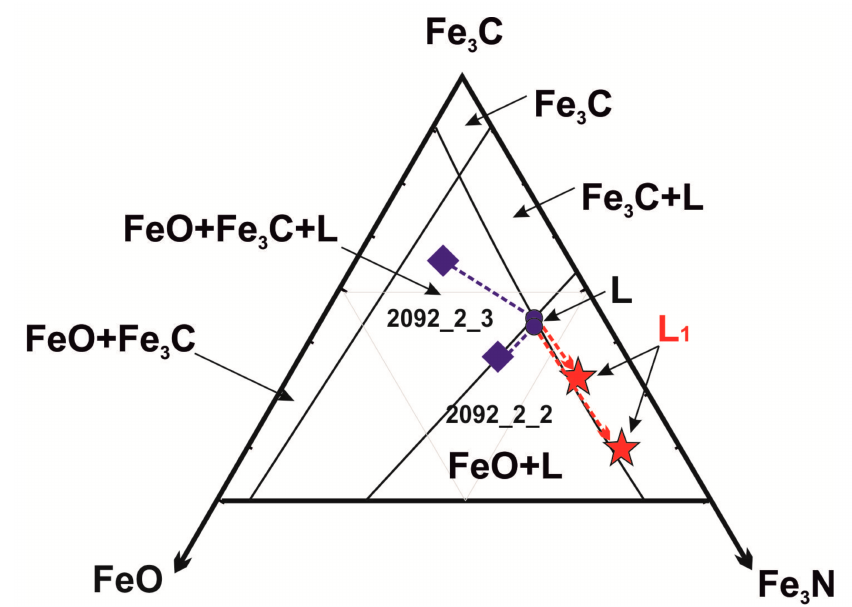
Figure 5. Fragment of FeO-Fe 3 C-Fe 3 N phase diagram at 7.8 GPa and 1350 ◦ C (mol %), with trends of melt composition changing in response to oxygen inputs. Rhombs are bulk compositions of starting samples. L = melt corresponding to initial composition of samples, without excess oxygen; L 1 = actual